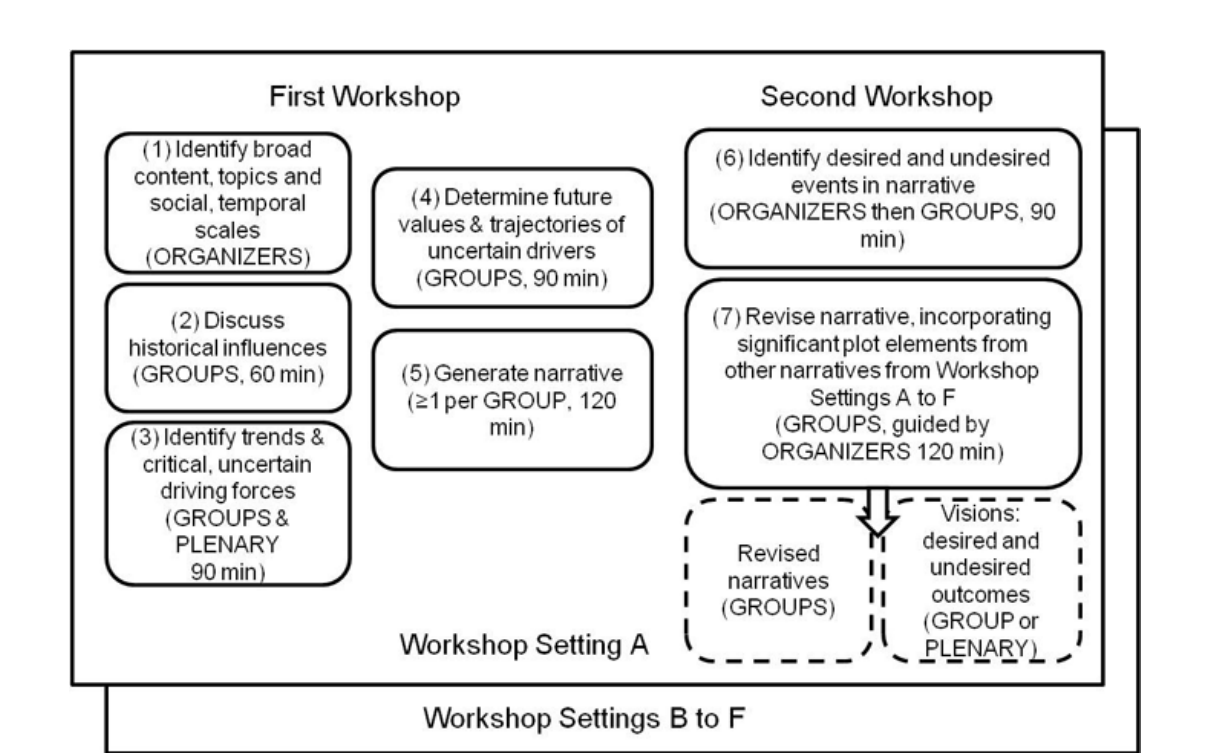
Fig. 2 . Mekong scenario elaboration